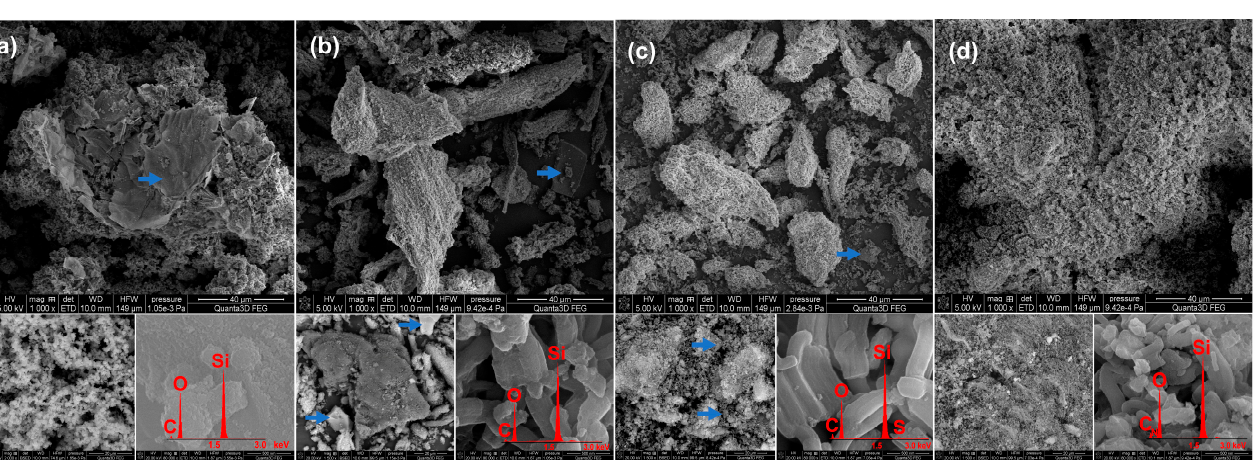
Figure 2. The SEM-EDX micrographs of GA-loaded MSMs samples: ( a ) MCM-41-GA; ( b ) SBA-15-GA; ( c ) SBA-SH-GA; ( d ) SBA-NH2-GA. Blue arrows represent the GA precipitates.